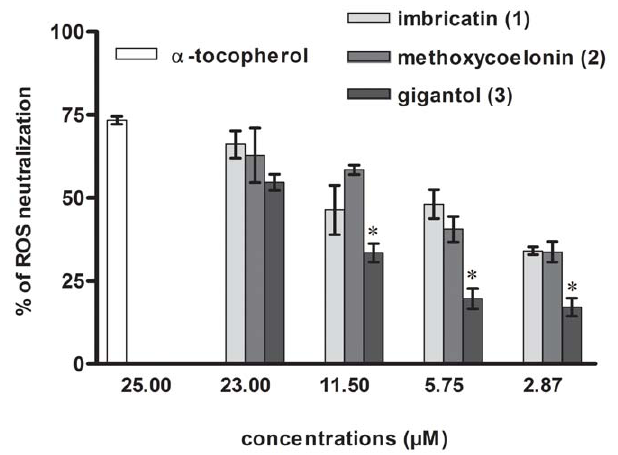
Figure 3. Reactive Oxygen Species (ROS) neutralization in H2O2 stressed HaCaT cells by stilbenoids 1–3. Results are expressed as percentages of total ROS neutralization in HaCaT cells calculated by comparison with the positive control (H2O2 stressed cell). Intracellular antioxidant properties of stilbenoids 1–3, considered as stem biomarkers, were evaluated on intracellular ROS neutralization. IC50 were calculated with more points than those represented on the graph. a -Tocopherol at 25 m M was used as a positive reference. (*) set at p , 0.05, gigantol (3) effect was statistically different from those of imbricatin (1) and methoxycoelonin (2).